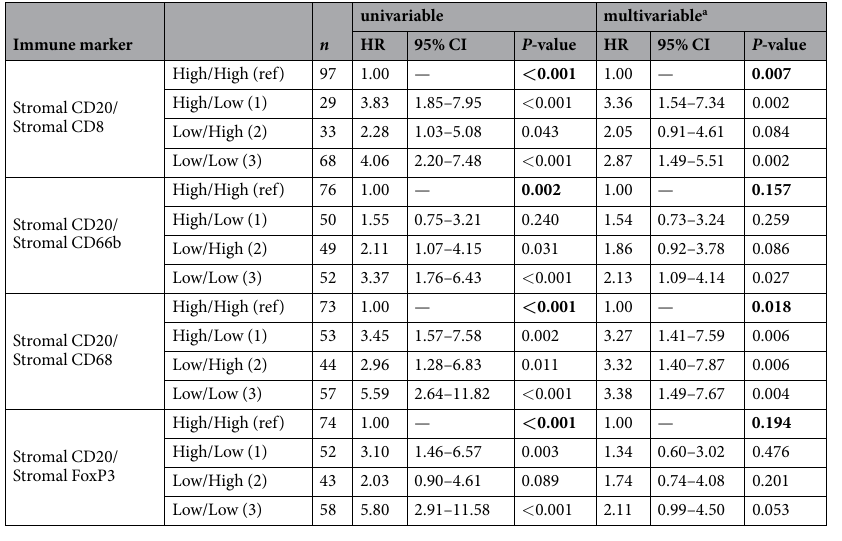
Table 4. Prognostic relations of immune cell subsets in CRC. a The Cox regression multivariable models included one categorical immune parameter, age, localization and stage, and were stratified by sex. Abbreviations: HR, hazard ratio; CI, confidence